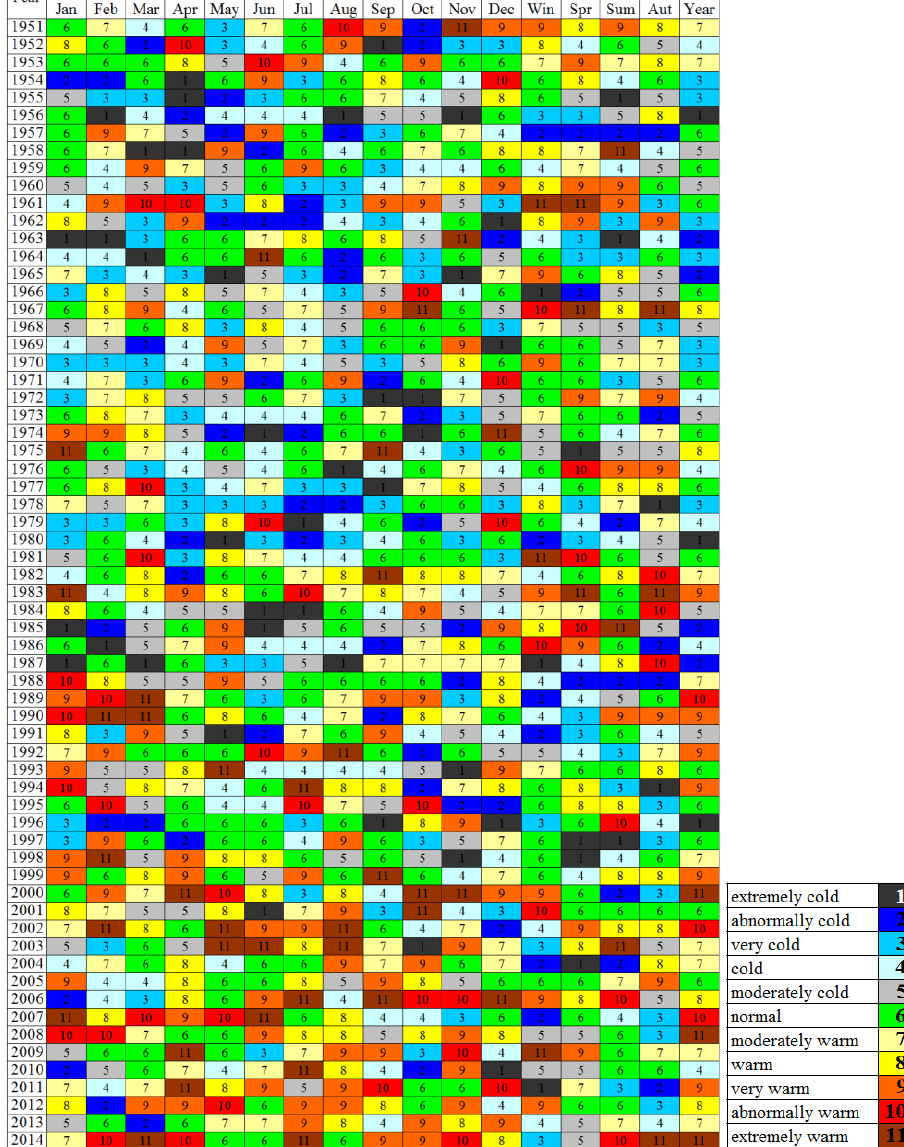
Figure 4. Quantile-based classification of monthly, seasonal and annual mean temperature in the studied region, 1951–2014.